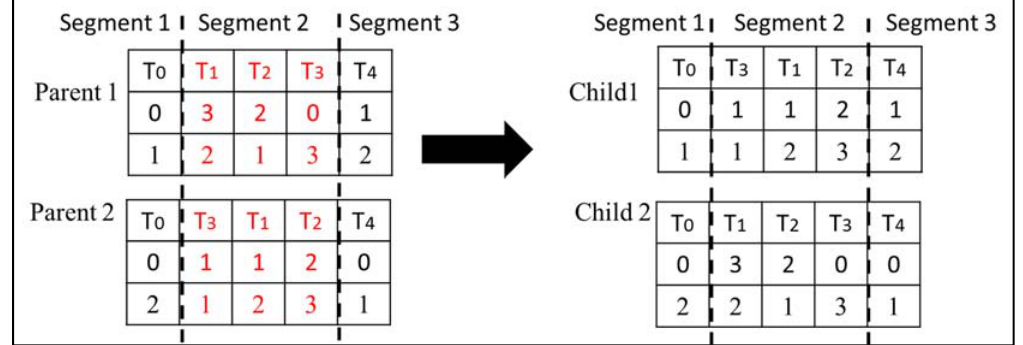
Figure 7. Crossover performed on the second segment.